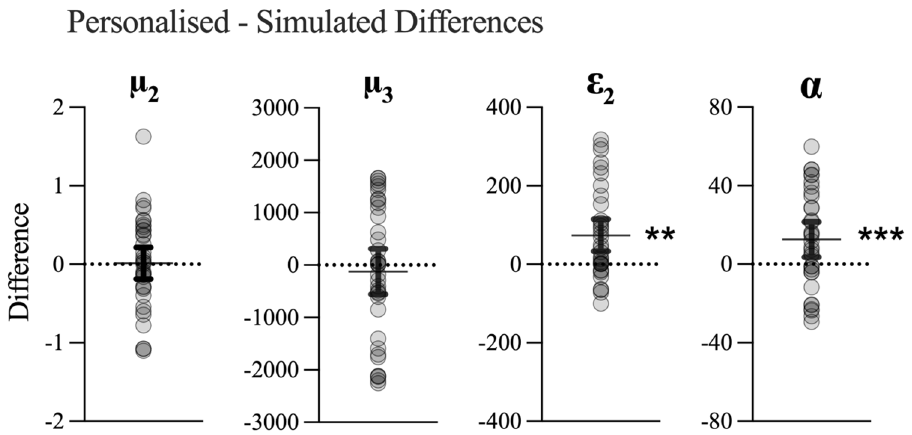
Figure 8. Differences in β coefficients between personalised and simulated models. Figure shows individual data points with means and 95%CIs. ** p < 0.01, ** p <